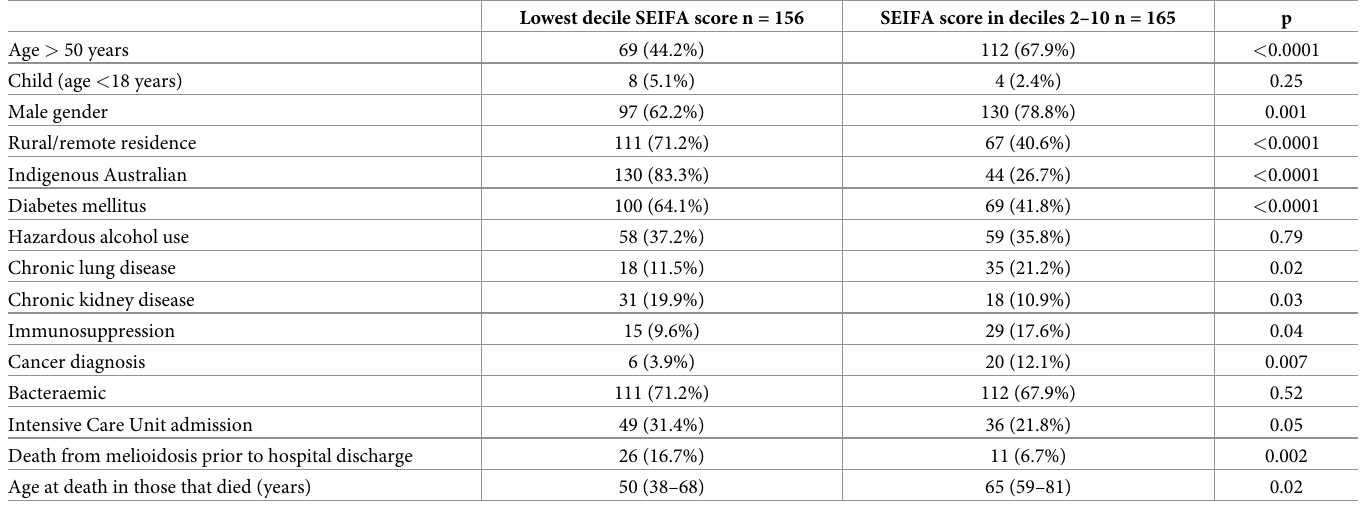
Table 4. Association between selected characteristics of the cohort and socioeconomic disadvantage (determined by SEIFA Index of Relative Socio-economic Disad- vantage